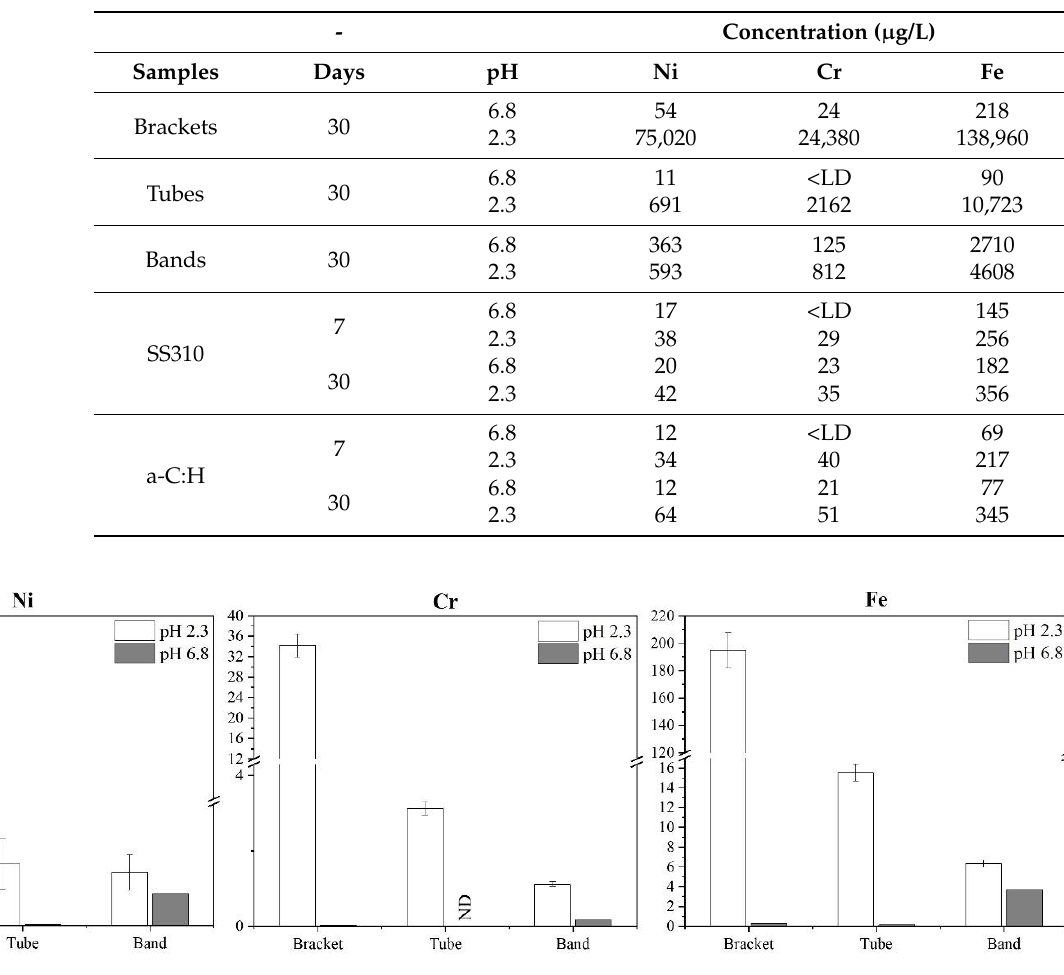
Figure 2. Average release rates of Ni, Cr, and Fe of fixed orthodontic components. ND: not detected.